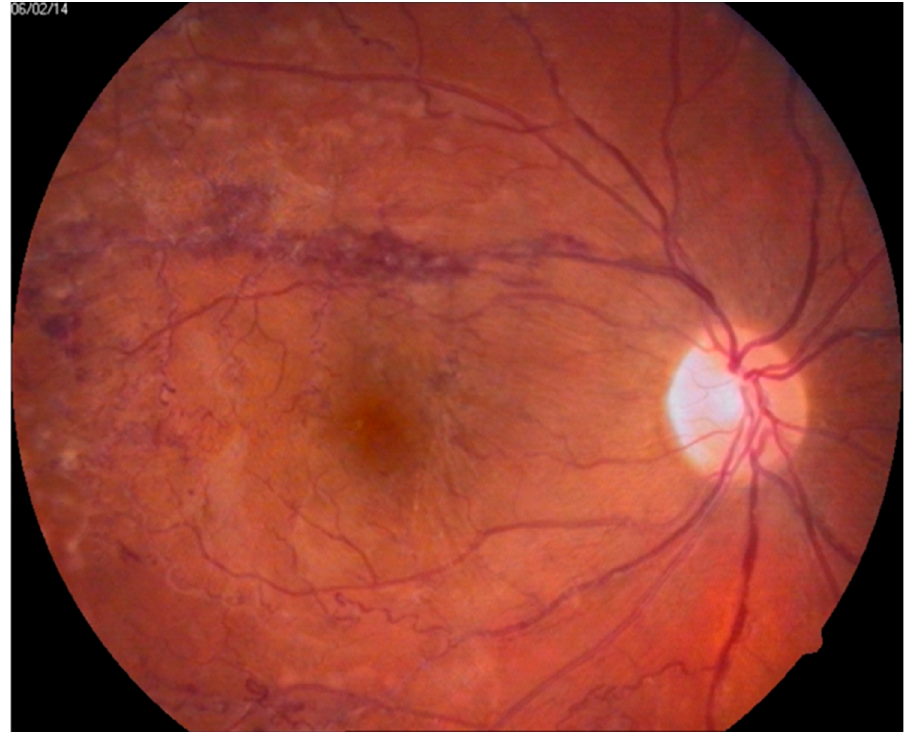
Figure 1. Color eye fundus photographs of patients with Behçet’s Disease. Fundus presents with vascular changes of the superior arcade, widened, irregular and tortuous veins, intraretinal hemorrhages and premacular inflammatory fibrosis.